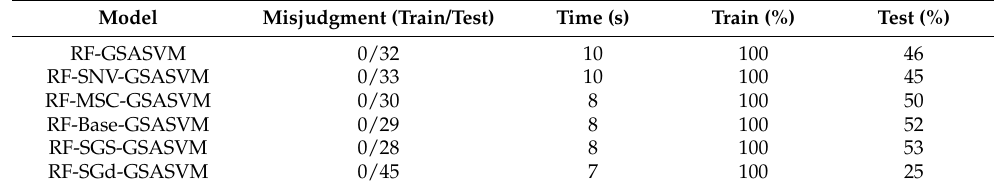
Table 8. The Ranman spectra after five different pretreatments are extracted using the random forest algorithm, and the GSA-SVM classification models are established using the extracted feature variables.